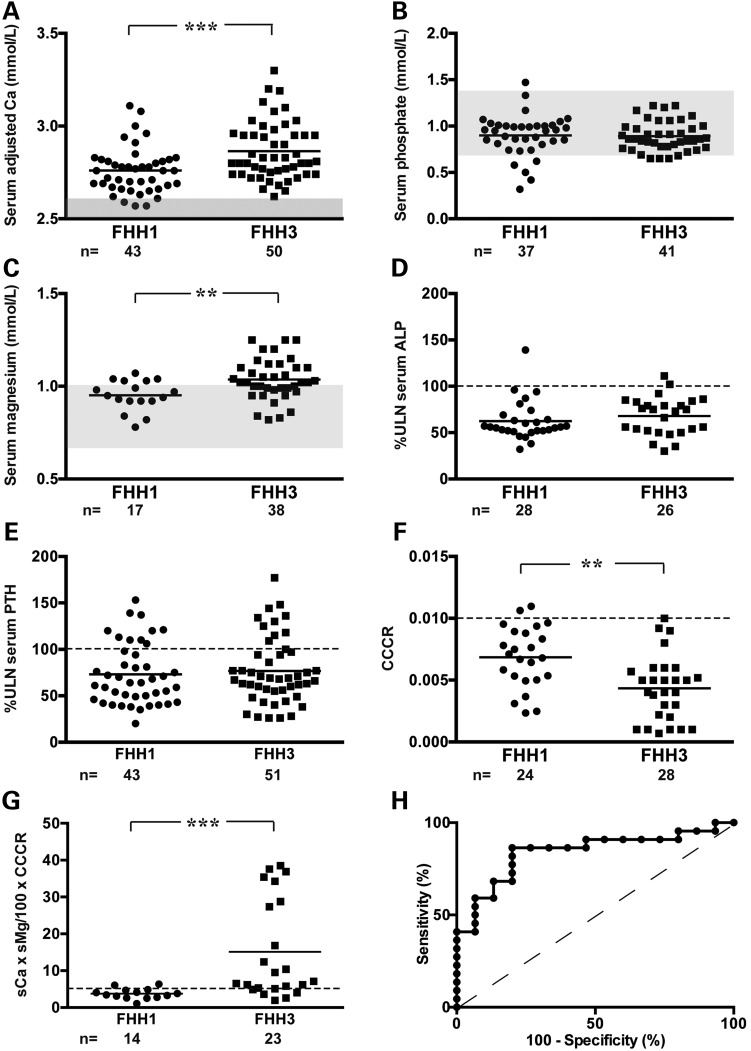
Comparison of biochemical phenotypes between FHH1 and FHH3. Scatter plots of serum concentrations of (A) adjusted-calcium, (B) phosphate, (C) magnesium, (D) ALP activity, (E) PTH, (F) urinary CCCR and (G) CMCR index, which is calculated as sCa × sMg/100 × CCCR, for FHH3 probands are shown. Such biochemical values are also provided for an age- and gender-matched cohort of previously reported FHH1 probands with CASR mutations (8). All biochemical parameters comprising the CMCR index were measured in millimole per litre. FHH3 probands, when compared with FHH1 probands, had significantly greater elevations of serum adjusted-calcium and magnesium concentrations, reduced CCCR values and elevated CMCR. Mean values for the respective groups are indicated by horizontal solid lines. The normal ranges (mean ± 2 SDs) for serum calcium, phosphate and magnesium are indicated by the grey areas. The ULN for the assay that was used for serum ALP activity and PTH concentrations are represented by the broken line. For CCCR, the lower limit (<0.01) for the consideration of hypocalciuria is represented by the broken line. For CMCR index, the cut-off value of 5.0, above which a diagnosis of FHH3 should be considered, is represented by the broken line. (H) ROC of discriminatory power of CMCR index to distinguish between FHH3 and FHH1. The CMCR had an AUC of 0.85, which was significantly greater than that of the reference line (P < 0.001). **P < 0.01, ***P < 0.001.